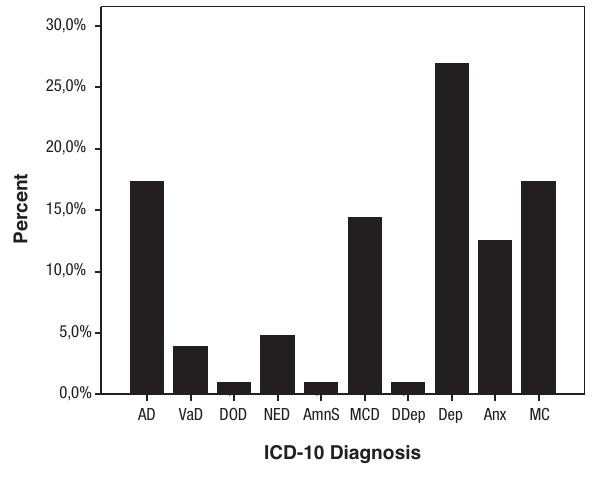
Graphic 1. Percentage of etiologic diagnosis, according to ICD-10 (n=104). AD: Alzheimer’s disease; VaD: Vascular dementia; DOD: Dementia secondary to other causes; NED: Non-specified dementia;